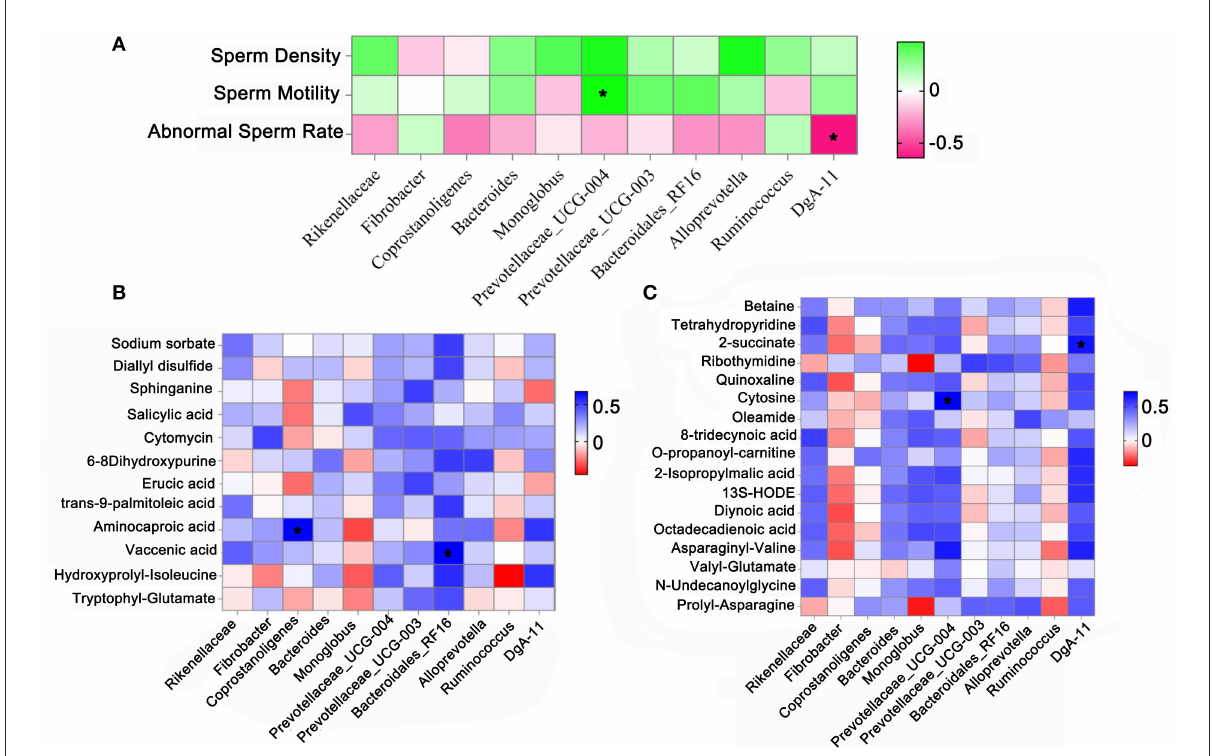
FIGURE7 (A) Correlation between gut microbes and sperm parameters. (B) Correlation between blood metabolites and gut microbes. (C) Correlation between testicular metabolites and gut microbes. * P <